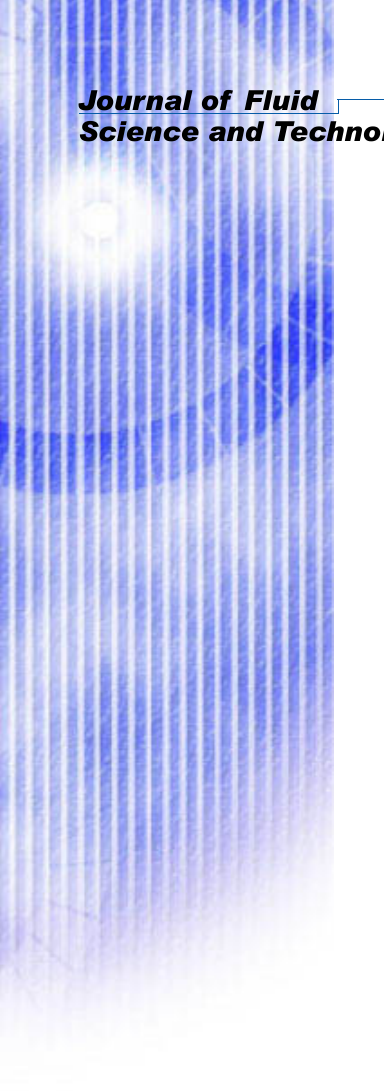
Fig.12 Sterilization rate of various bacteria at V=353.7 m/s, σ =0.037, and P=80 MPa